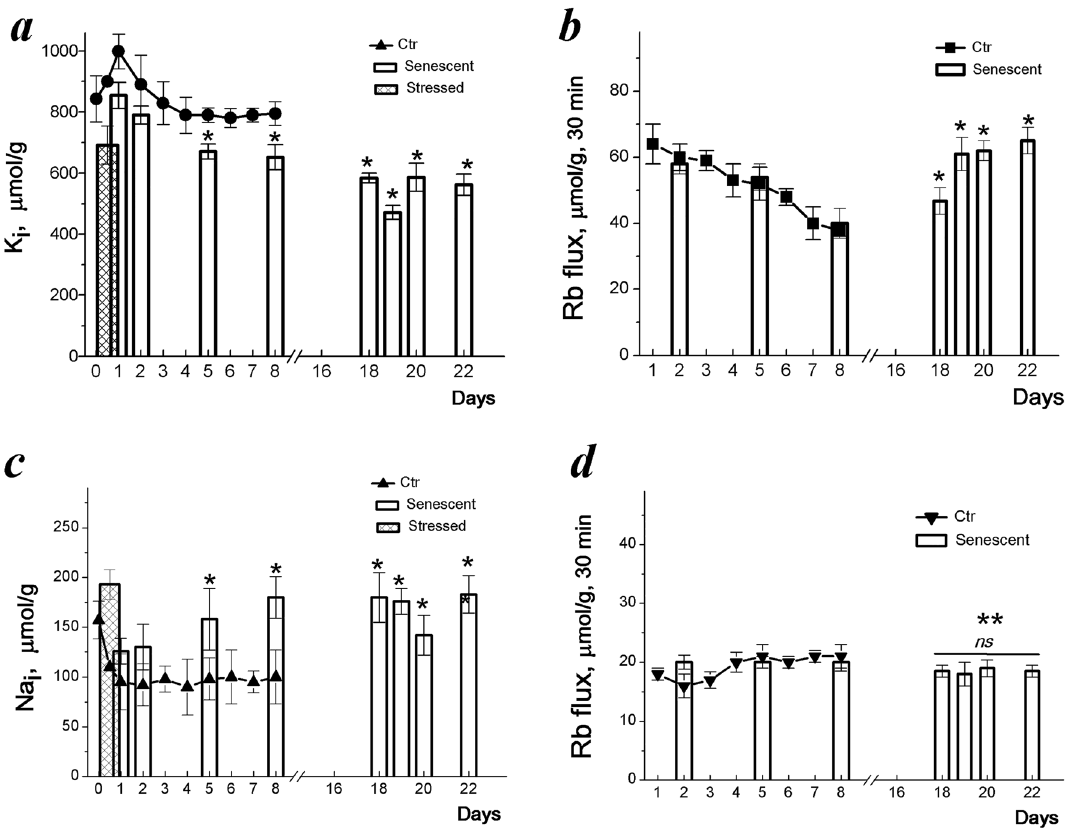
Figure 2. Intracellular K + and Na + content and Rb + influxes during senescence development in stress-induced hMESCs. Ion content in young (Ctr) and senescent hMESCs were assayed during the first 8 days of cultivation and then, in late senescent cells between 18th and 22nd days. ( a , c ) Cell K + ( a , circles ) and Na + ( c , triangles up) content in young hMESCs during culture growth and in stressed hMESCs during senescence development ( bar graphs ). Dashed bar graphs represent cation content just after treatment of cells with 200 μM H 2 O 2 for 1 h. ( b , d ) Ouabain-sensitive ( b, squares ) and ouabain-resistant ( d , triangles down ) Rb + influxes in cycling hMESCs during culture growth and in stressed hMESCs during senescence development ( bar graphs ). Data presented as means ± SD of six (the first 8 days) and of three (18–22 days) independent experiments. Significant difference was calculated using one-way ANOVA-Tukey tests for young (Ctr) and senescent cells, * p < 0.05; ns, not significant, ** p <